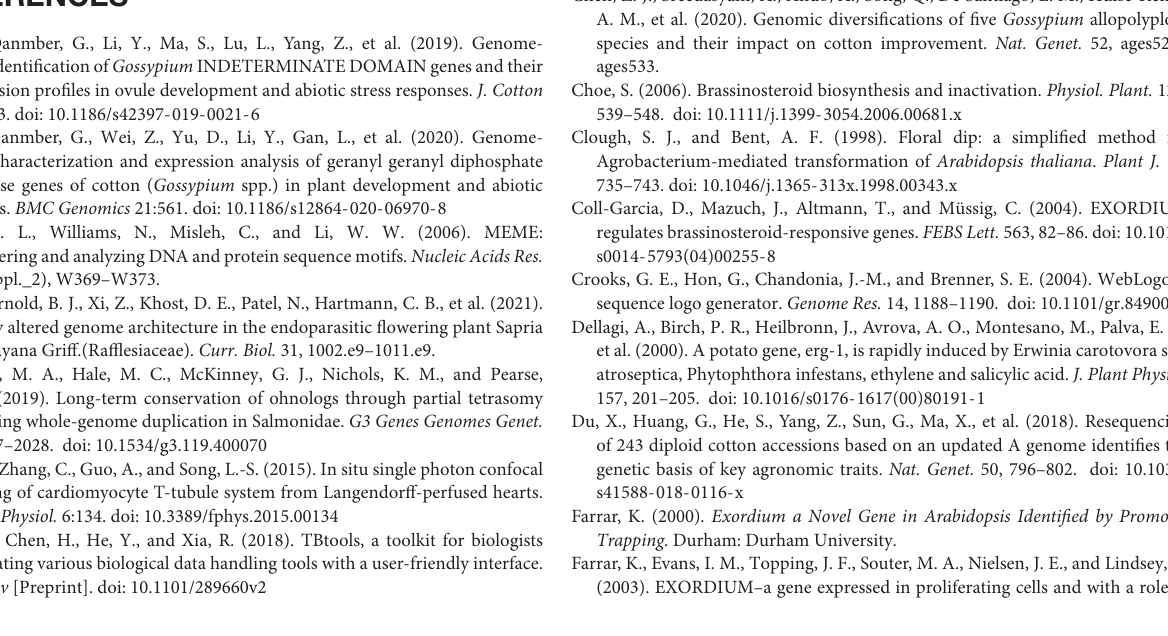
Supplementary Table 1 | Oligonucleotide primers used in this study. Supplementary Table 2 | Duplication type information for the 39 GhEXO genes. Supplementary Table 3 | Calculated expression values and primary data from qRT-PCR assays in this